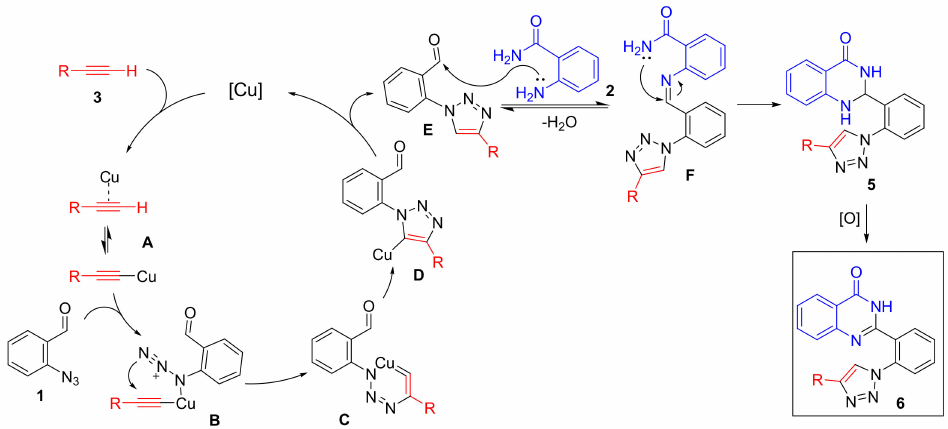
Figure 5. Proposed mechanism for the formation of triazoylquinazolin-4(3H)-one 6